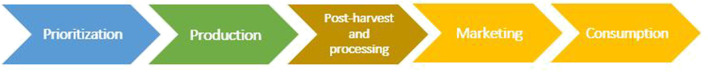
Development stages of food systems for future smart foods Source: FAO (62).